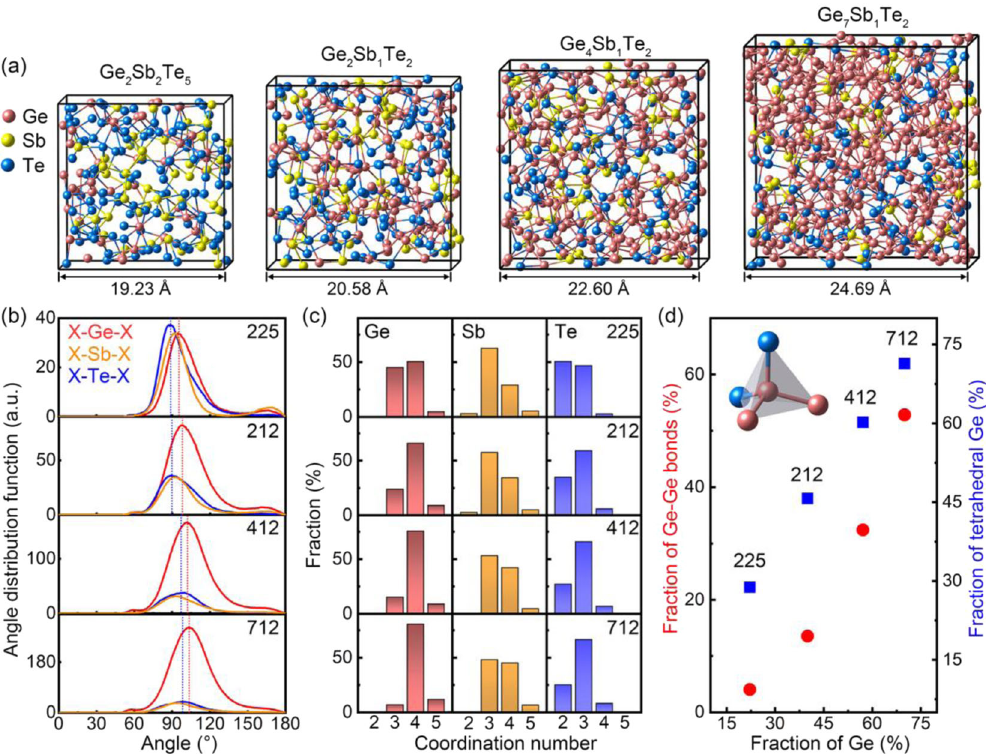
Fig. 2 Structural features of amorphous GST models. a Atomic structures of amorphous Ge 2 Sb 2 Te 5 , Ge 2 Sb 1 Te 2 , Ge 4 Sb 1 Te 2 , and Ge 7 Sb 1 Te 2 generated via melt – quench AIMD simulations. Ge, Sb, and Te atoms are rendered as red, yellow, and blue spheres, respectively. b The angular distribution functions (ADF), c the distribution of the coordination number (CN) and d the fraction of homopolar Ge – Ge bonds and tetrahedral Ge motifs for the four amorphous GST models. The inset in d shows a typical tetrahedral Ge motif with two homopolar Ge – Ge